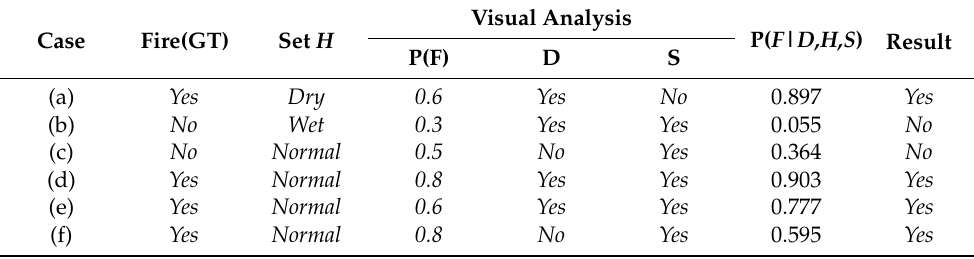
Visual Analysis